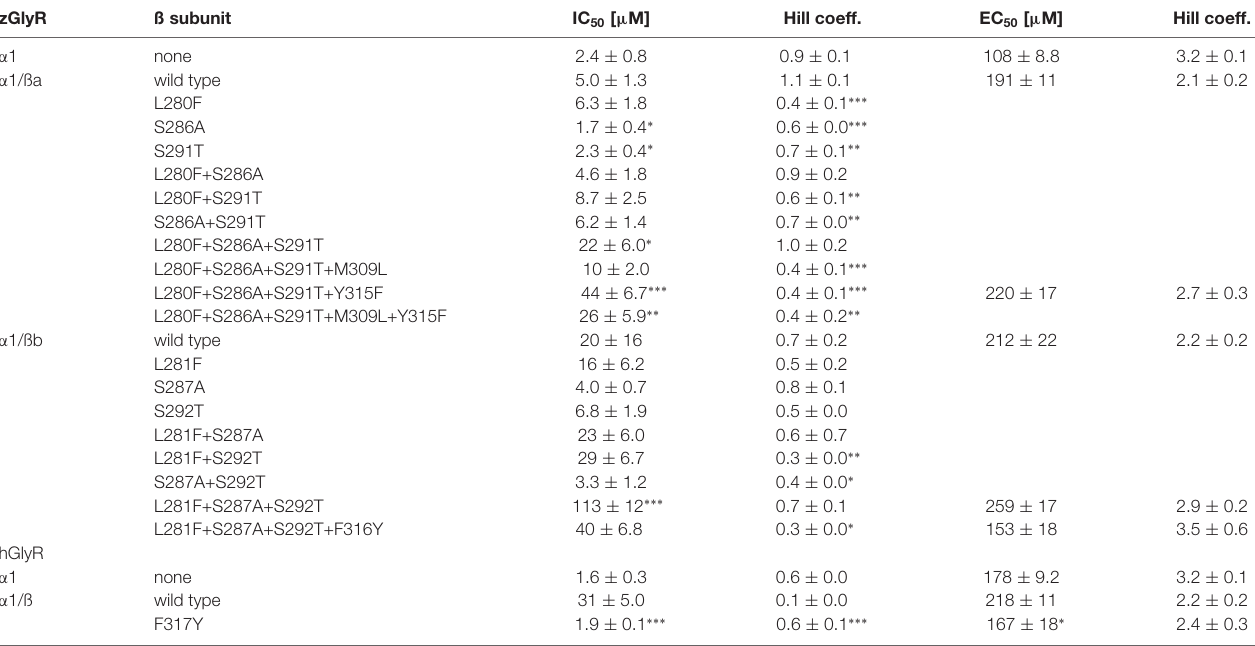
TABLE 3 | Summary of modified ß subunits effects on picrotoxin and glycine sensitivity. zGlyR ß subunit IC 50 [ µ M] Hill coeff. EC 50 [ µ M] Hill